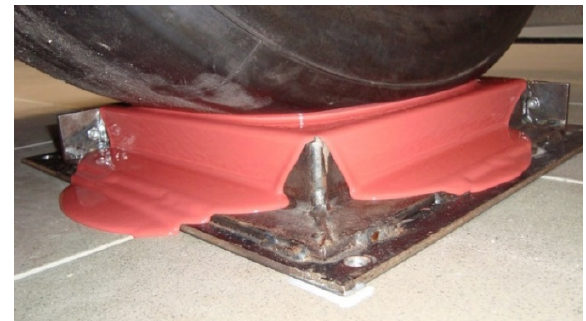
Figure 6. Making the contact deformations mold.